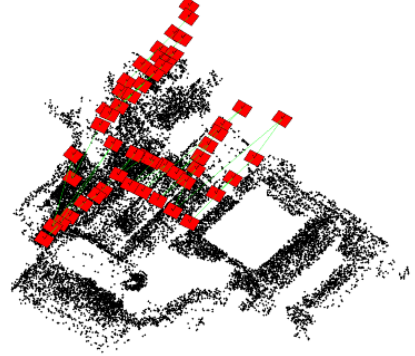
Fig. 5. Camera position / attitude and 3D points after the image orientation